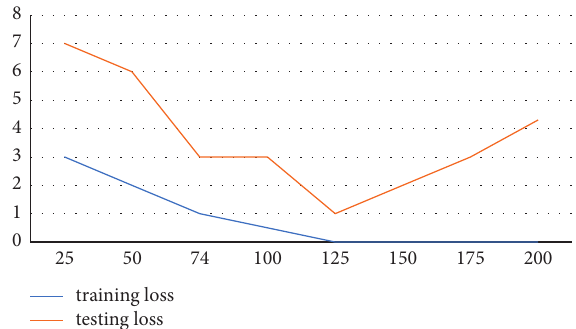
Figure 11: The convergence loss function history of the 8 × 8 grid.